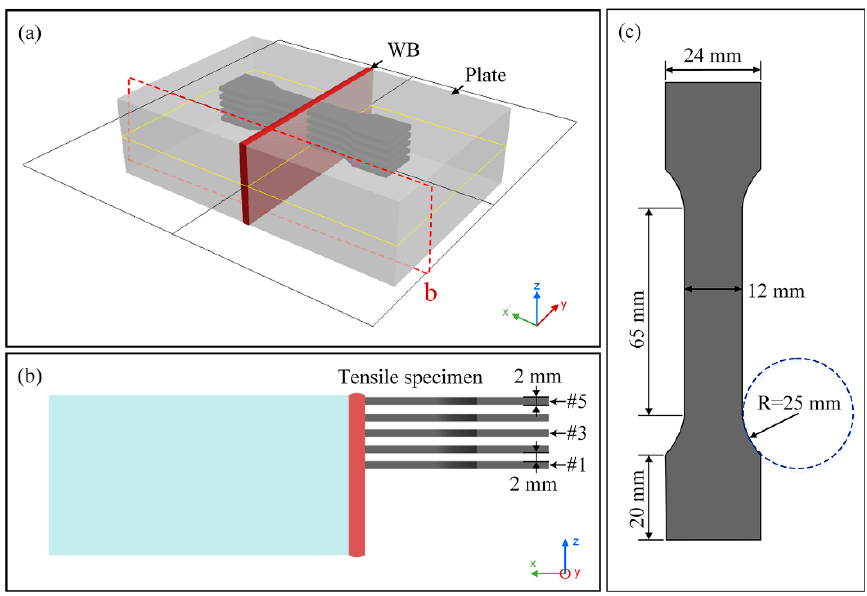
Figure 3. Tensile test specimens: ( a , b ) sampling location; ( c ) sample dimensions.